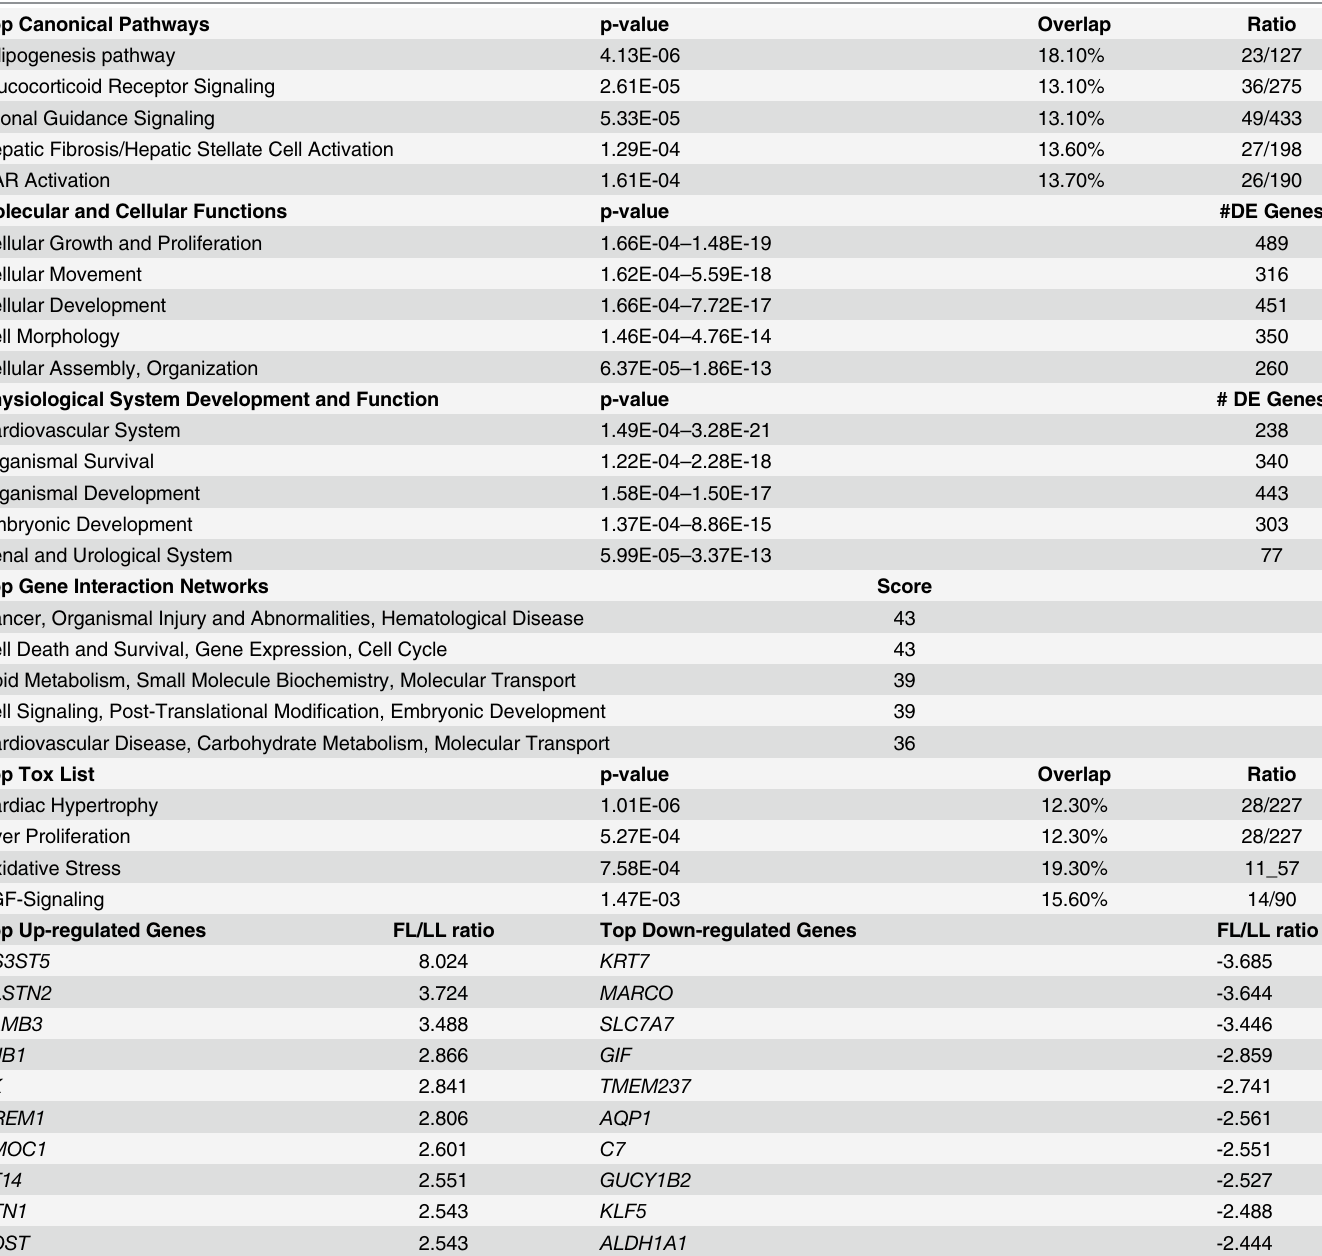
Table 3. Ingenuity Pathway Analysis of DE Genes in Abdominal Fat of FL and LL Cockerels (7